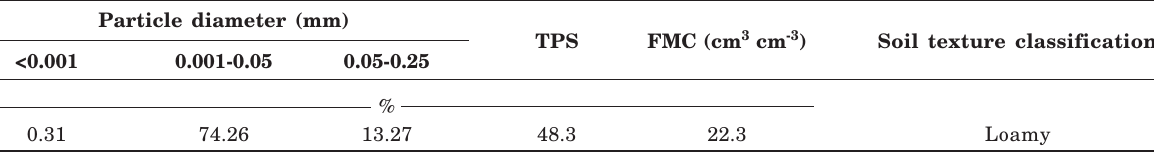
Table 2. Mechanical composition of experimental soil: particle diameter, total soil porosity (TSP) and field moisture capacity (FMC) and soil texture classification